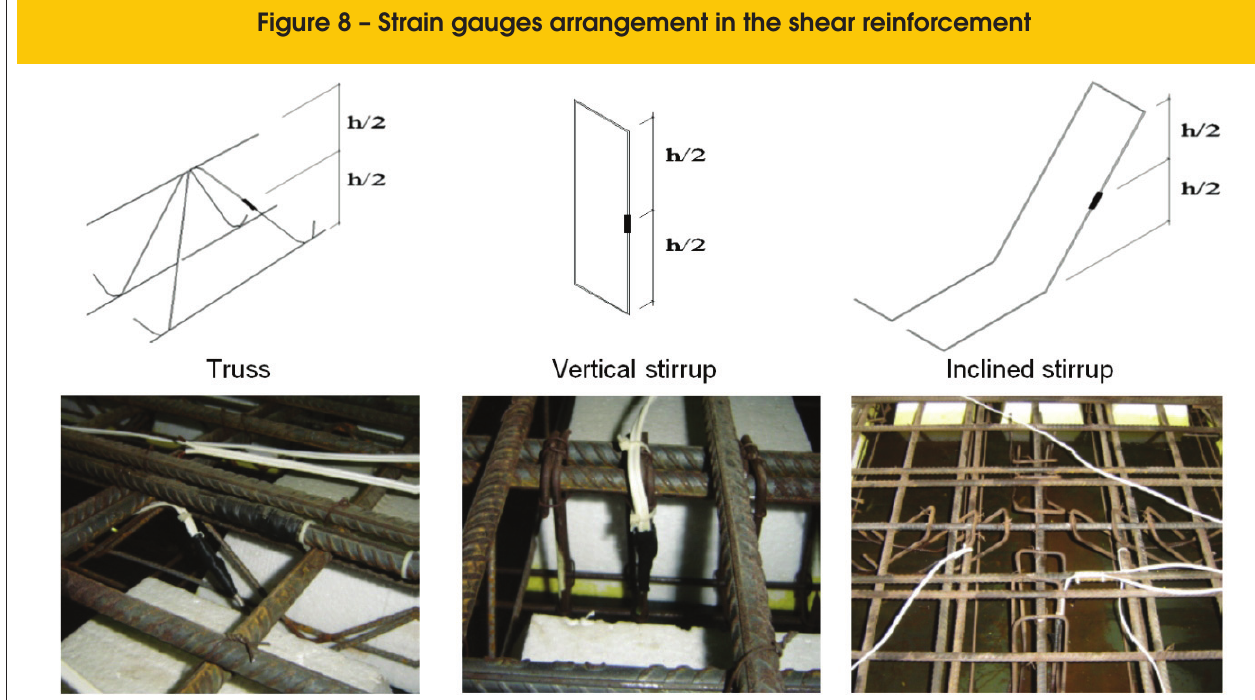
Figure 8 – Strain gauges arrangement in the shear